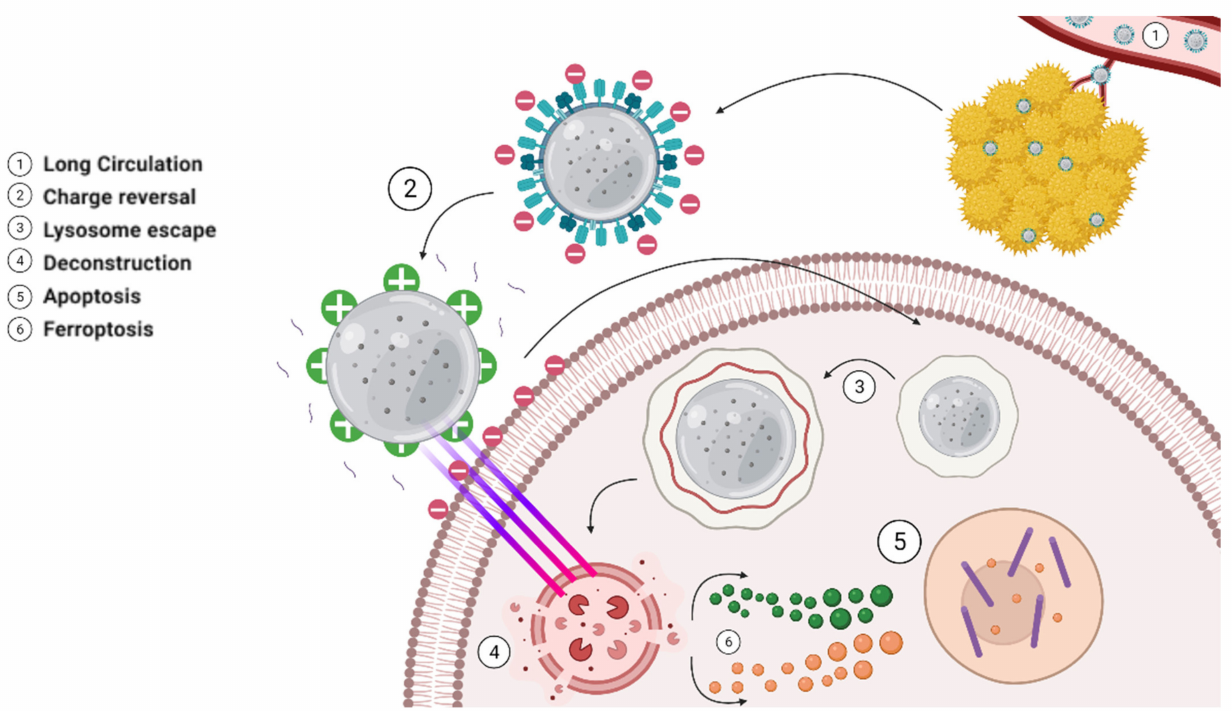
Figure 8. UCNP and DOX were loaded into gel nanoparticles and modified with PEI and DMMA to con- struct a nanolongan schematic with multiple transformations and corresponding anticancer